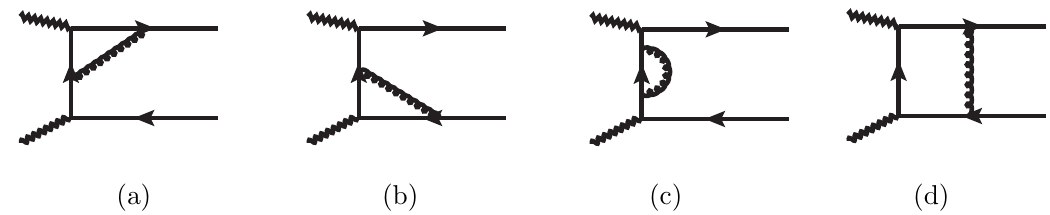
Figure 2 . Diagrammatical representation of the NLO contribution to the QCD amplitude F (cid:22) ( p; q ) de(cid:12)ned in